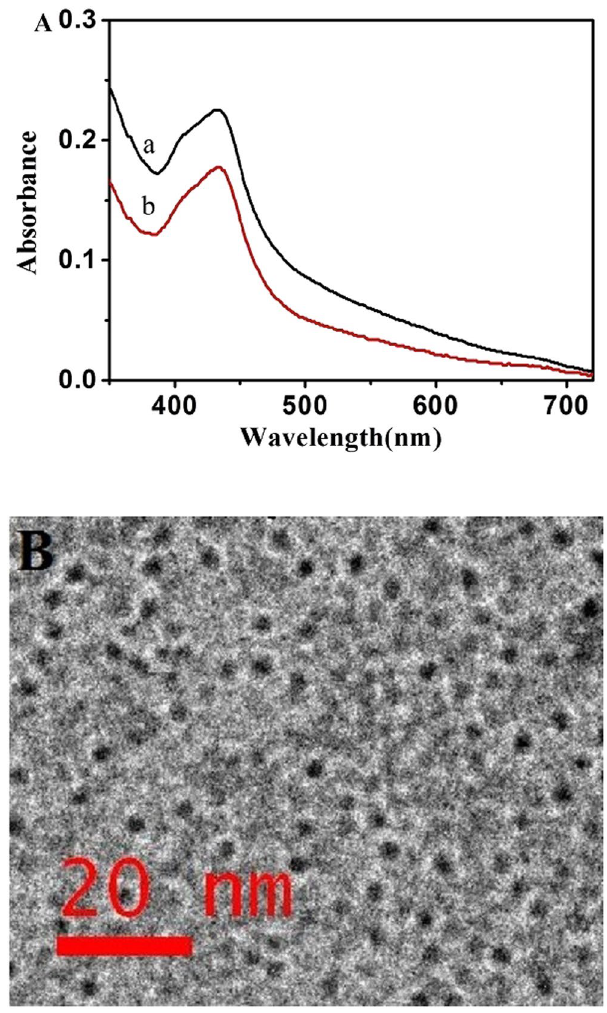
Figure 2. ( A ) UV − vis spectra of DNA-AgNCs in the absence and presence of 10 μ M K + ions. ( B ) TEM images of